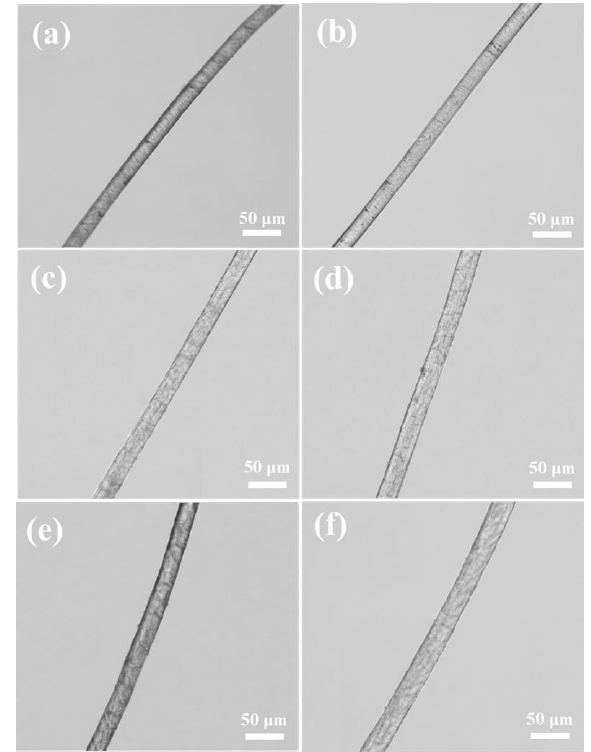
Figure 11. Optical measurements of camel hair diameter before and after swelling in the water and ethanol–water systems: ( a ) Ethanol:water = 0:100 ( v / v ), before swelling; ( b ) Ethanol:water = 0:100 ( v / v ), after swelling; ( c ) Ethanol:water = 60:40 ( v / v ), before swelling; ( d ) Ethanol:water = 60:40 ( v / v ), after swelling; ( e ) Ethanol:water = 80:20 ( v / v ), before swelling; ( f ) Ethanol:water = 80:20 ( v / v ), after swelling.